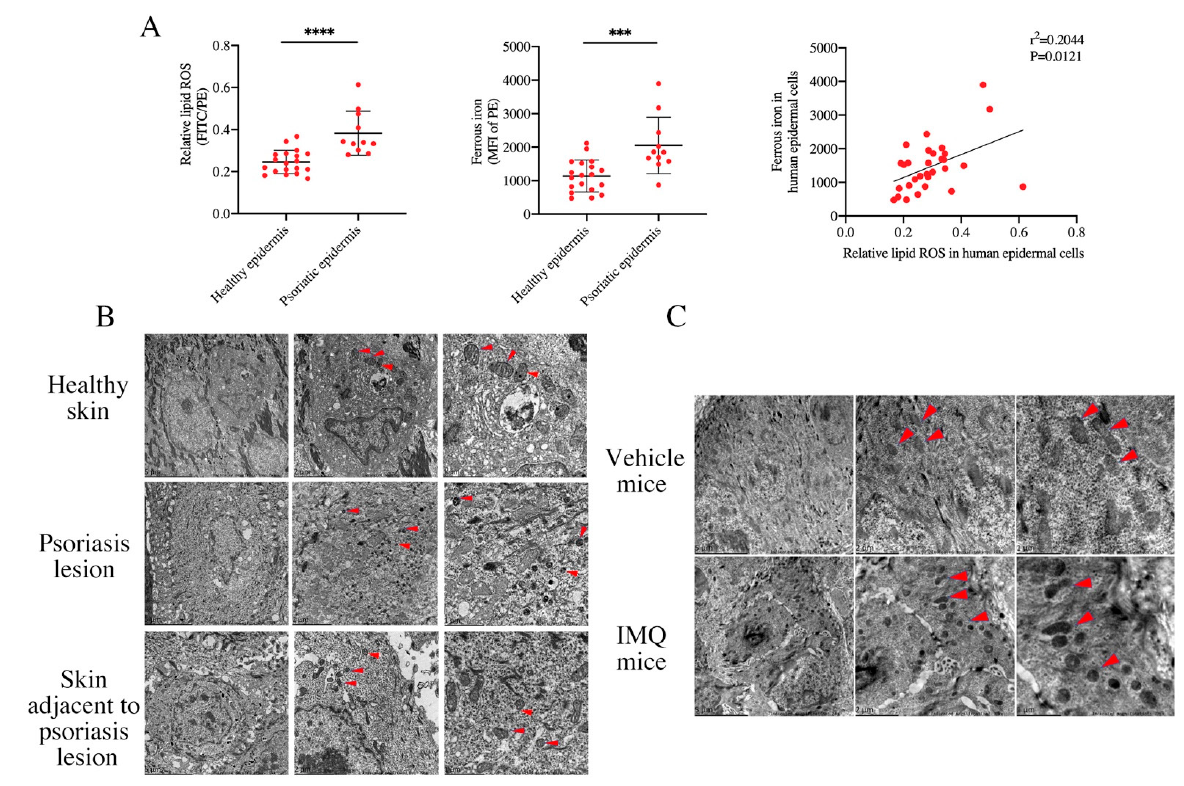
Figure 1. Ferroptosis is activated in the epidermis of psoriasis vulgaris samples. ( A ) Levels of lipid peroxidation and ferrous iron (MFI of PE channel) in epidermis samples derived from normal controls ( n = 19) and psoriatic skin lesions ( n = 11), the relationship between lipid peroxidation and ferrous iron. ( B ) Representative TEM images of normal control skin, psoriatic skin lesion, and its adjacent skin. Red triangles indicate mitochondria. Scale bars: 5 µ m (left), 2 µ m (middle), and 1 µ m (right). ( C ) Representative TEM images of shaved dorsal skin from IMQ-treated mice and vehicle-treated mice. Red triangles indicate ferroptosis-related mitochondria. Scale bars: 5 µ m (left), 2 µ m (middle), and 1 µ m (right). Data represent the mean ± SEM: *** p < 0.001, **** p < 0.0001. Two-tailed Mann–Whitney U test was used.